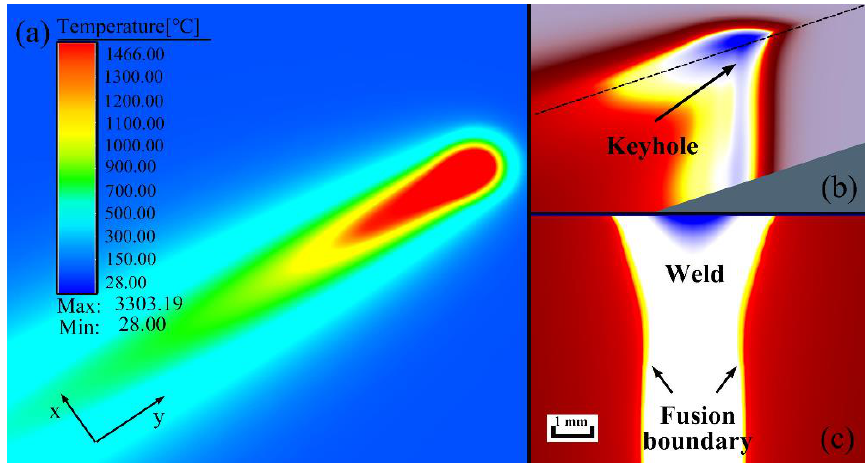
Figure 4. Simulated heat transfers at the preheating temperature of 78 °C. ( a ) Upper surface; ( b ) Longitudinal section; ( c ) Cross section.